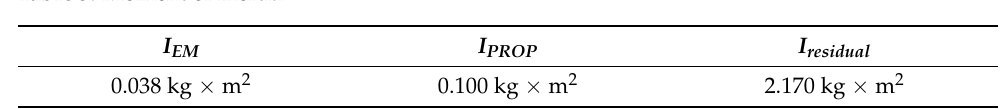
Table 3. Moment of inertia.